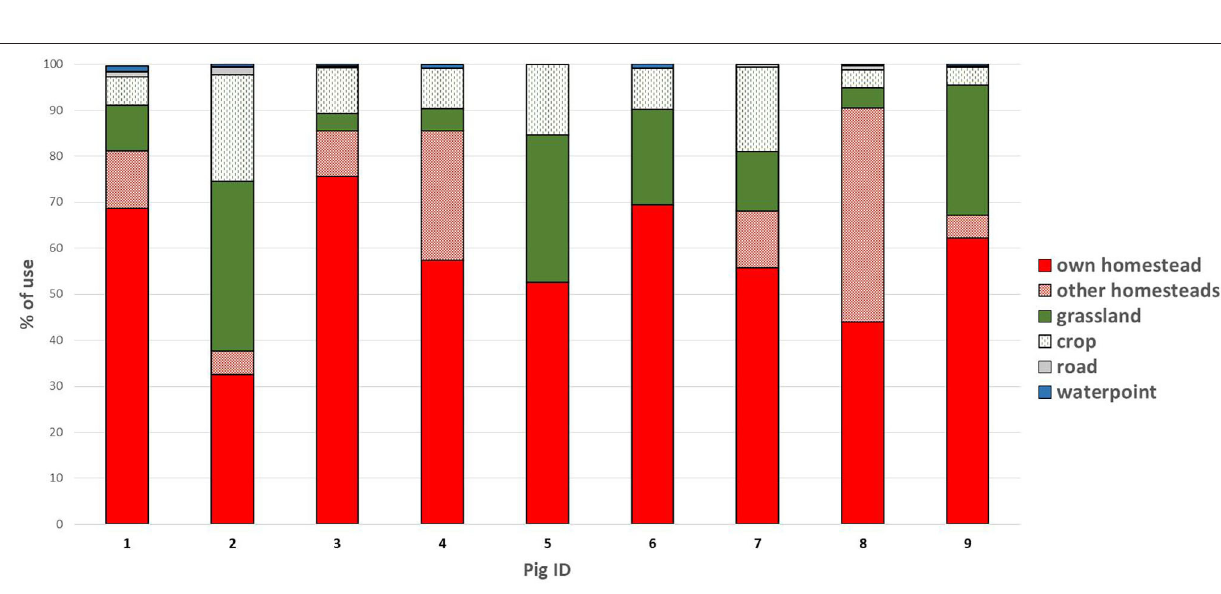
Frontiers in Veterinary Science |